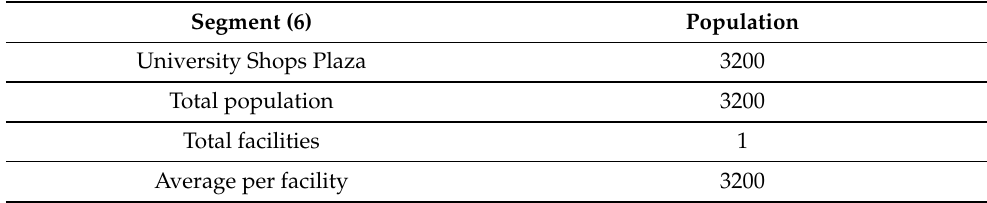
Table 8. Descriptive Statistics for University